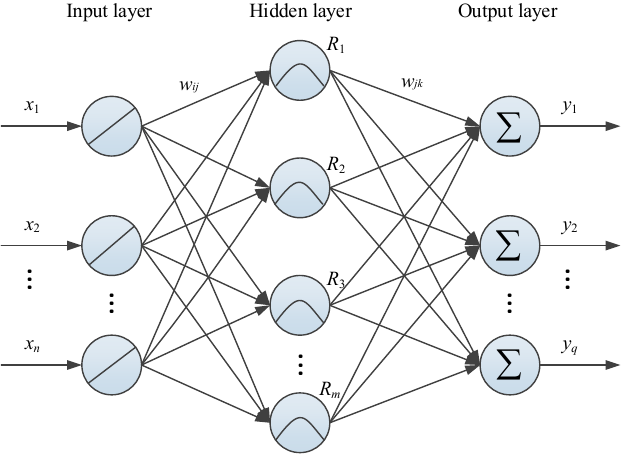
Figure 1. A typical three-layer RBF neural network.